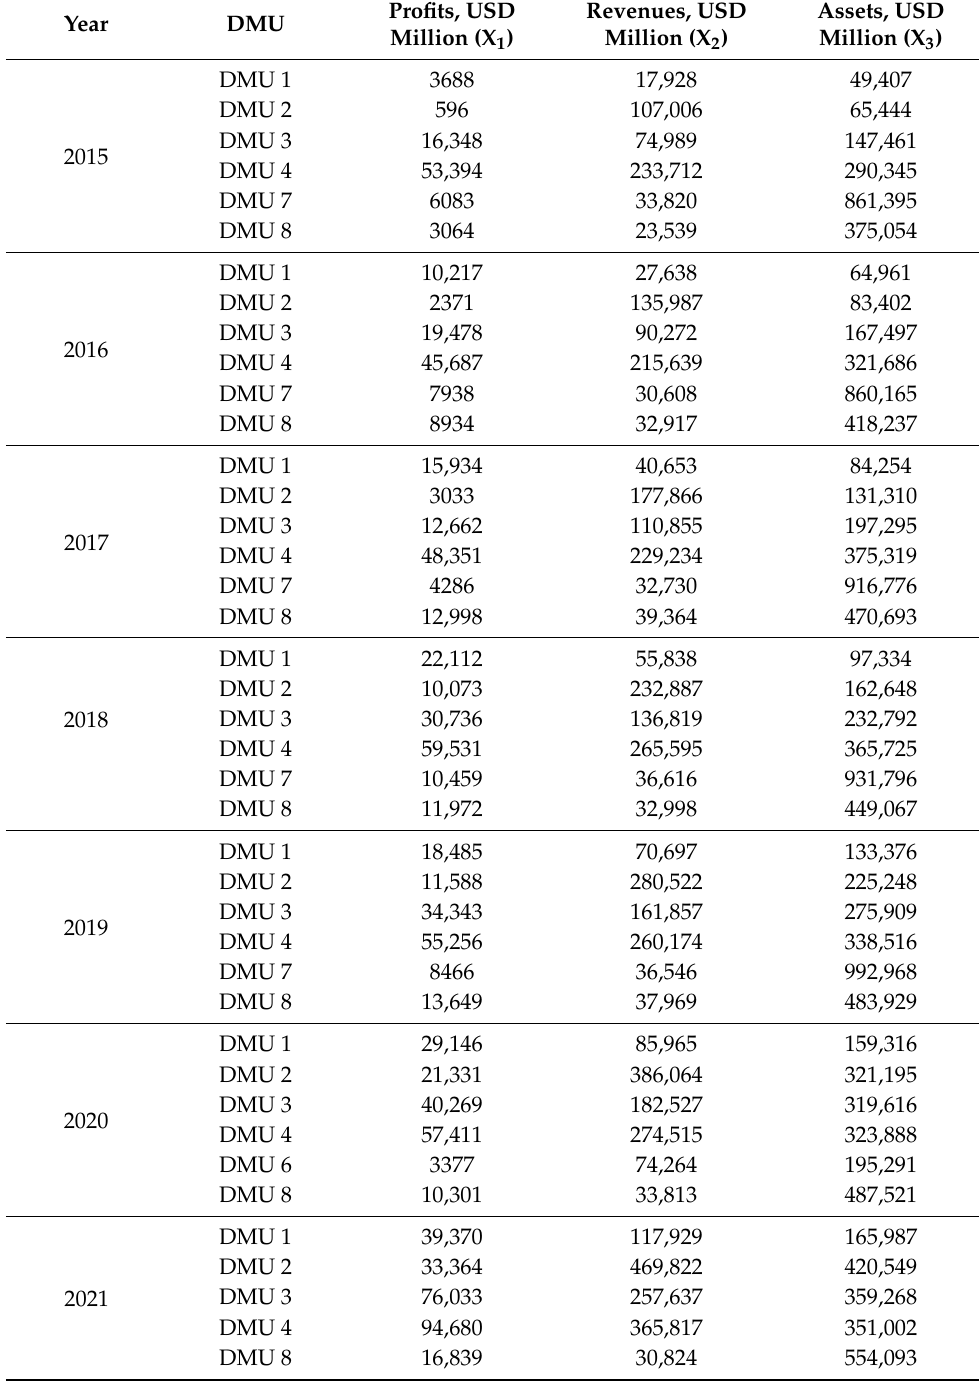
Table A2. Data for cluster 2 for regression analysis